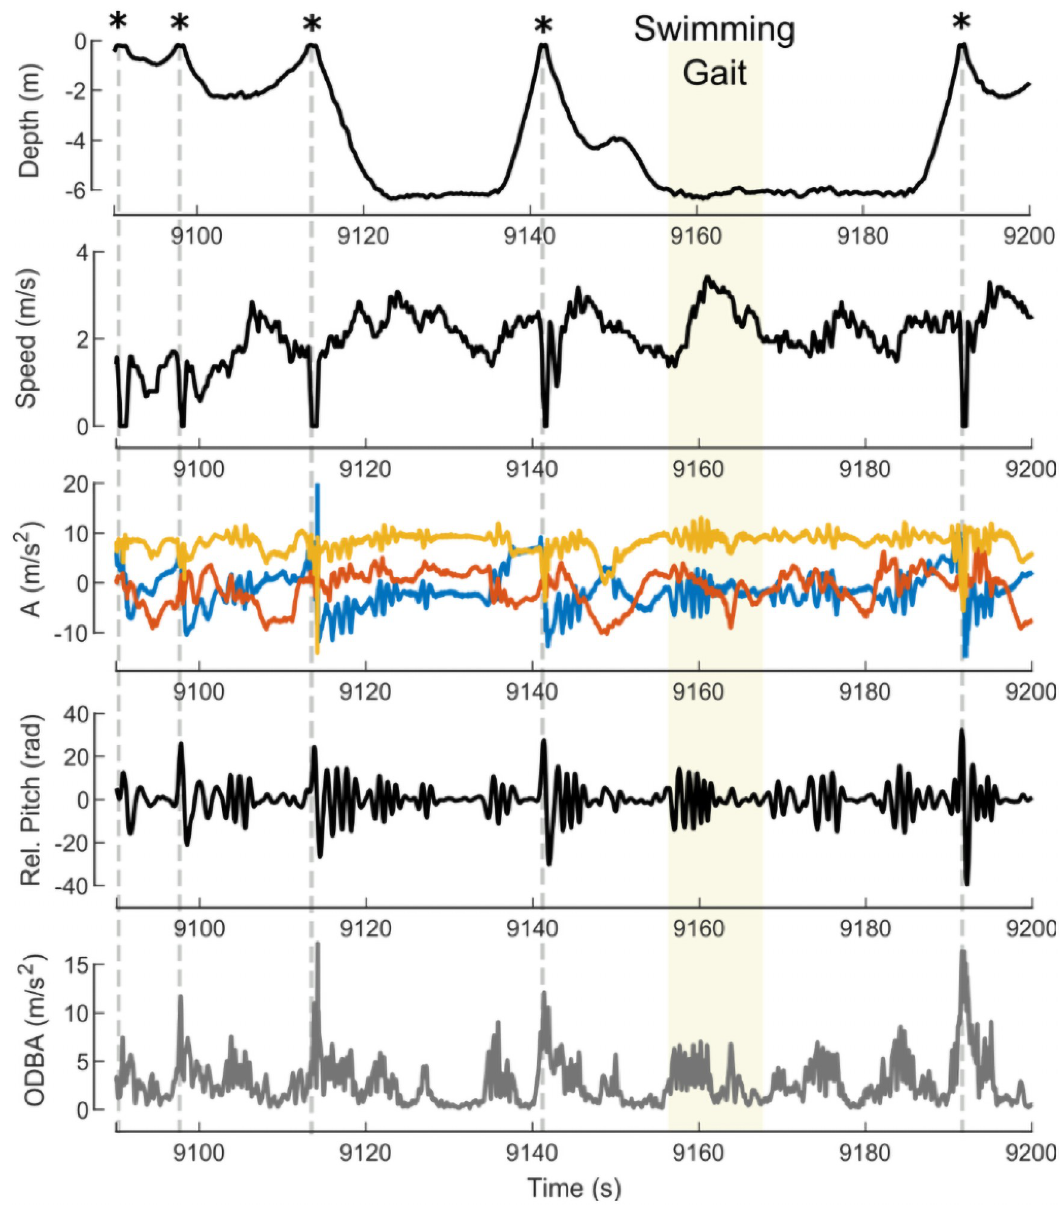
Fig 4. A representative section of swimming data. Surfacings are indicated with ( � ), and an example bought of swimming is highlighted. During this example, the animal uses a fluke and glide gait to move through the